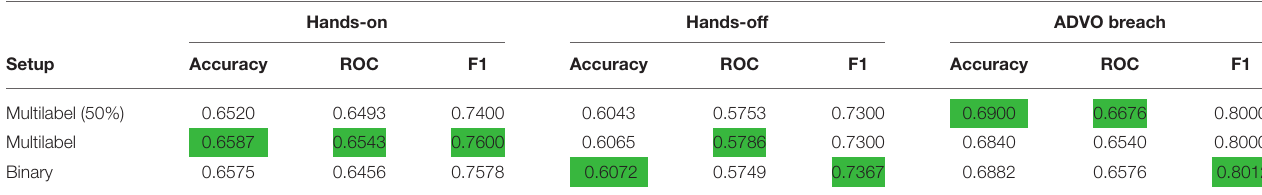
TABLE 7 | Performance comparison of multilabel and binary classification setups for each offense type (best results are highlighted in green). Hands-on Setup